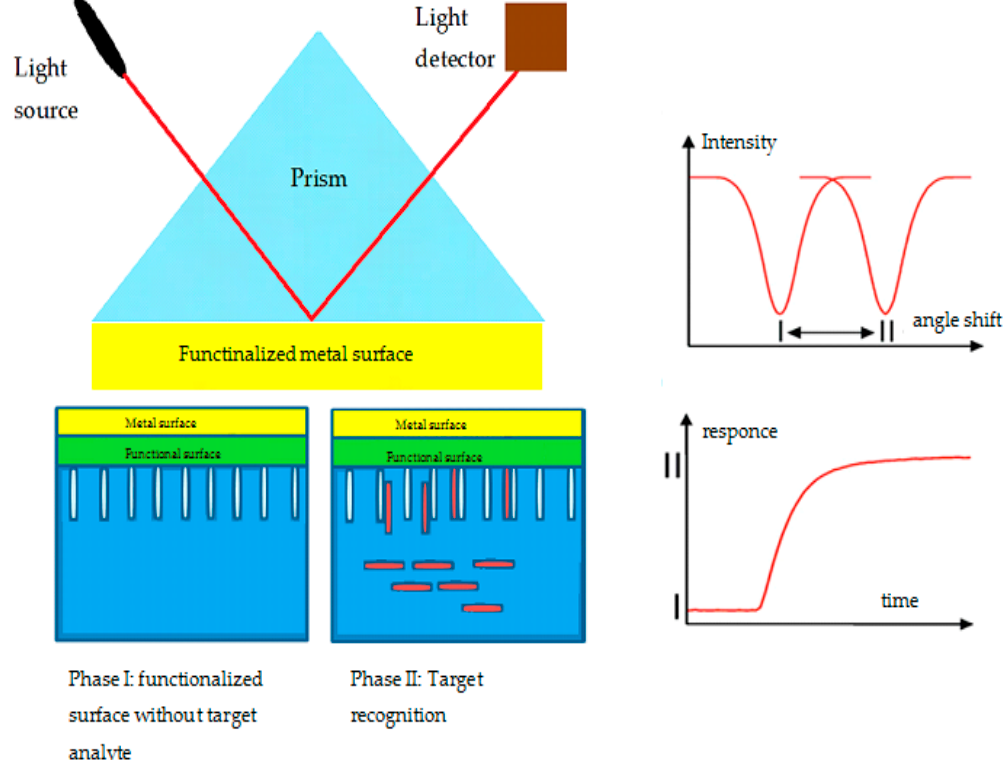
Figure 10. Schematic of surface plasmon resonance (SPR) biosensor design (left) showing the response functioning and the detection response from recognition of a biomarkers (right) [137].